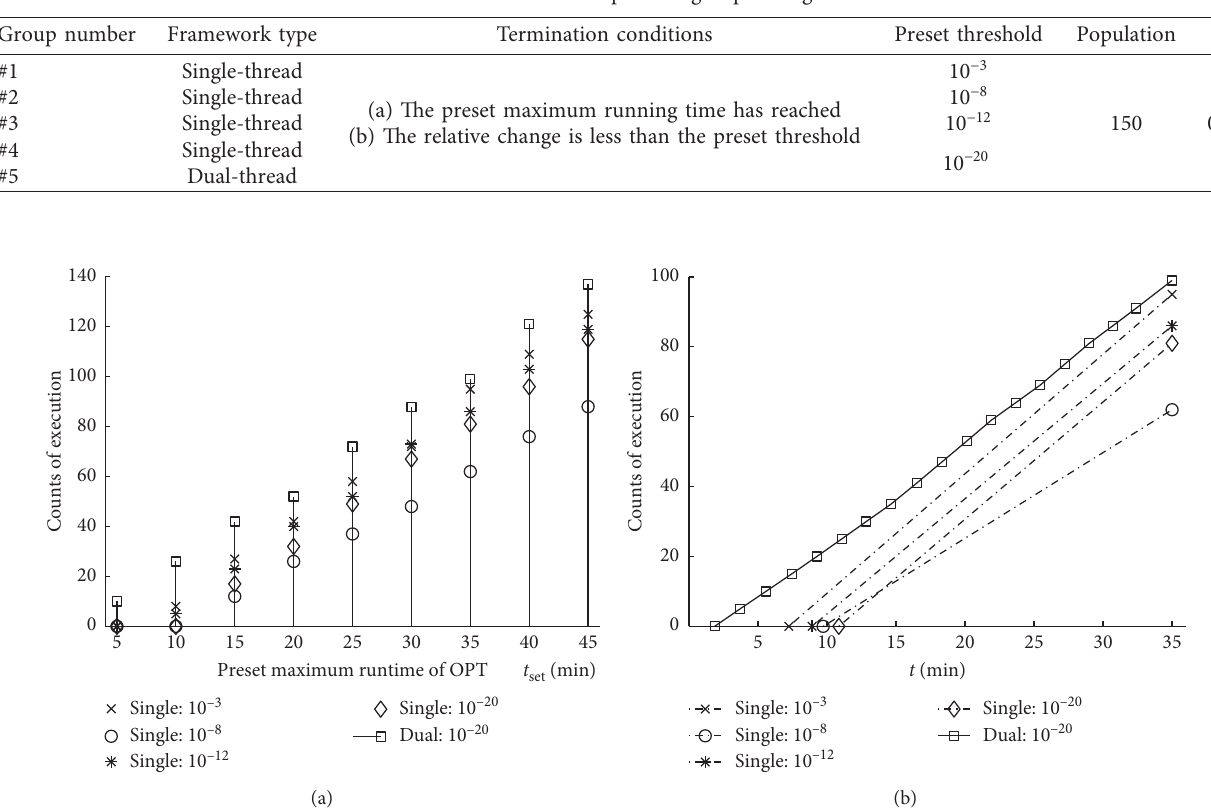
Table 4: Table of comparative group settings.